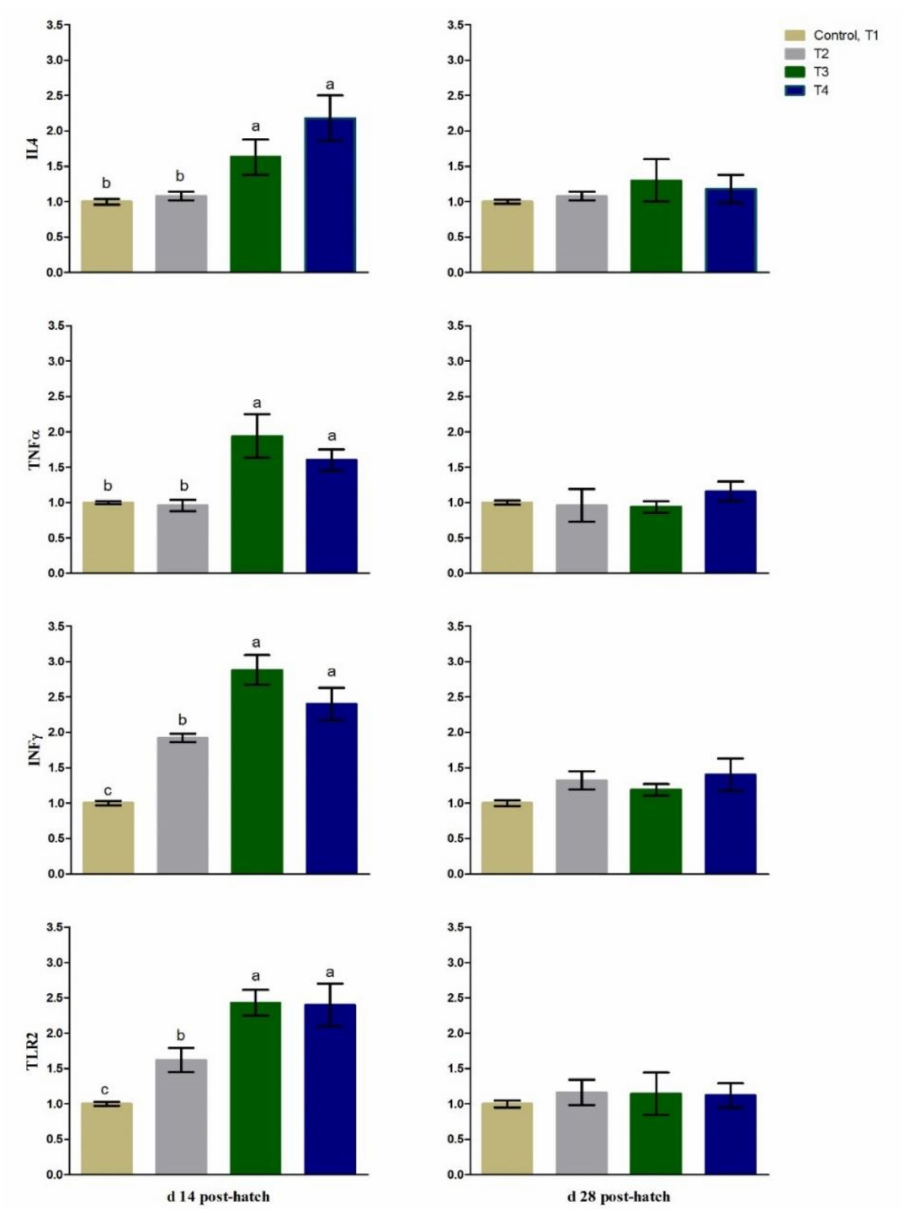
Figure 6. Splenic gene expression at day 14 and day 28 of age in layer-type chicks exposed to fasting (control, T1) or early feeding on a layer starter diet (T2), a layer starter diet contained 3% molasses (T3), and a broiler starter diet (T4) during the first 72 h post-hatching. IL4, interleukin 4; TNF α , tumor necrosis factor α ; INF γ , interferon gamma; TLR2, Toll-like receptor 2. Expression of control is taken as 1.0. Data are presented as mean ± SE. a–c Means with different letters are significantly varied at p <